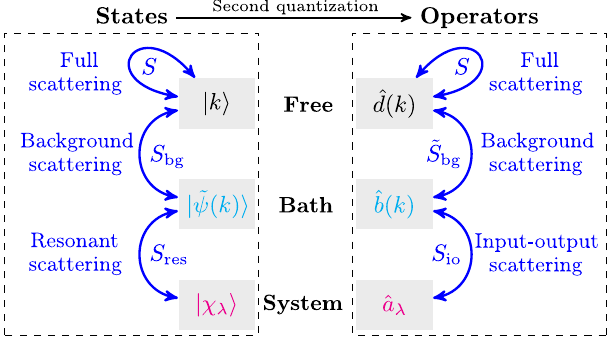
FIG. 3. Schematic of the different d.o.f. and scattering con- nections in the Feshbach projection formalism for potential scattering problems. The full scattering matrix S can be used to relate asymptotically free states or operators to each other. The background scattering S arises from a basis transformation of bg the free states into the bath states. The bath states scatter via S res on the system states, which span part of the region where the scattering potential V ð r Þ is nonzero. Similarly on the operator level, the scattering between bath operators that are coupled to the system is given by the input-output scattering matrix S . To io obtain the full scattering matrix, a background scattering con- ˜ S tribution has to be bg